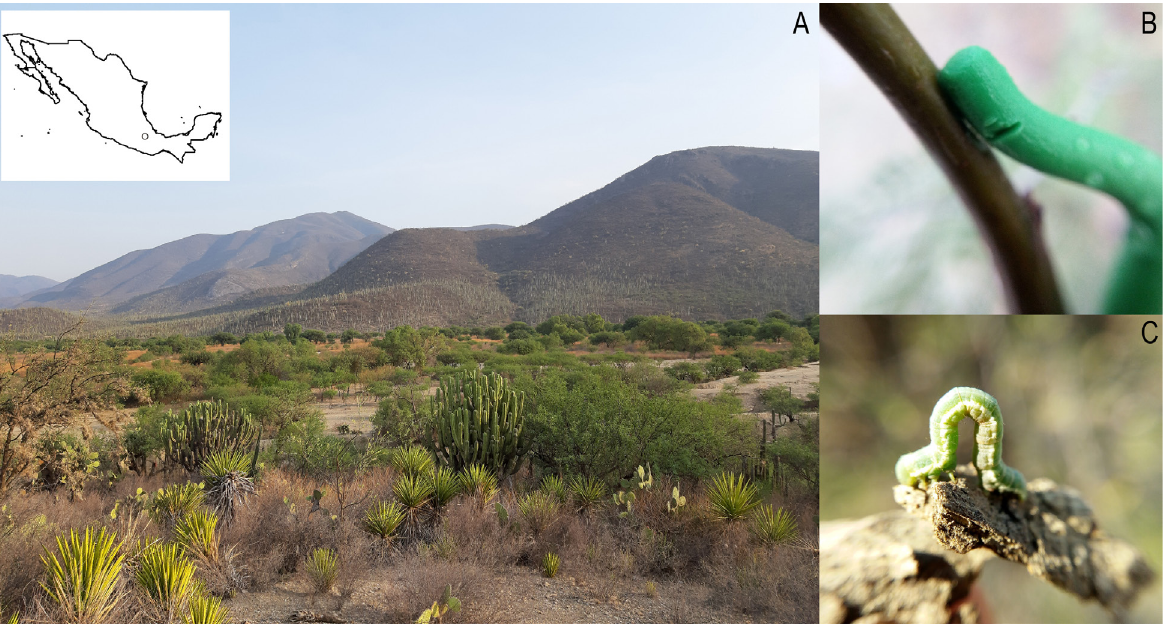
Fig 1 . A. Study area within the Helia Bravo Hollis botanic garden (Zapotitlán Salinas, Puebla, Mexico), highlighting the area dominated by the thorny shrub Prosopis laevigata (Fabaceae). B. Dummy caterpillar with a mark left by an ant species. C. Lepidoptera larvae from the Geometridae family observed in the study